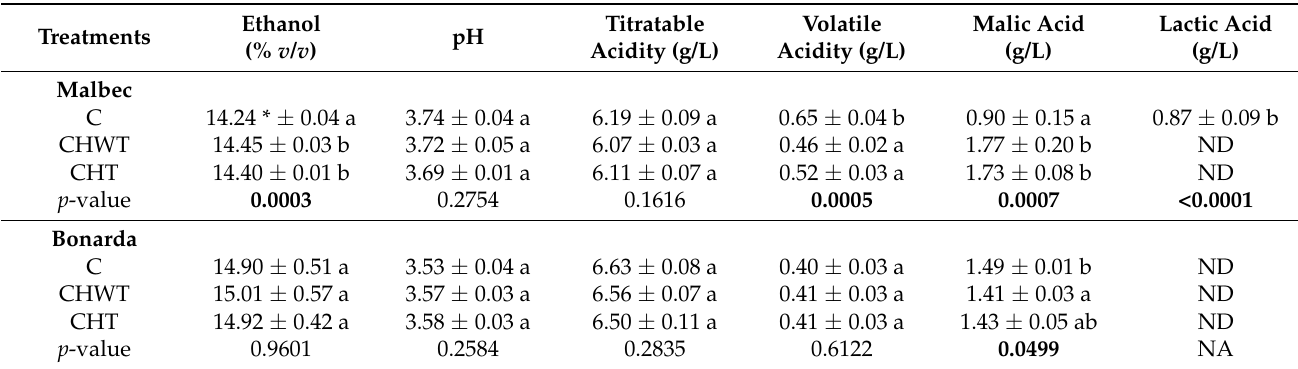
Table 1. General analytical parameters of Malbec and Bonarda wines obtained applying vine-shoot chips during winemaking (Experiment A).